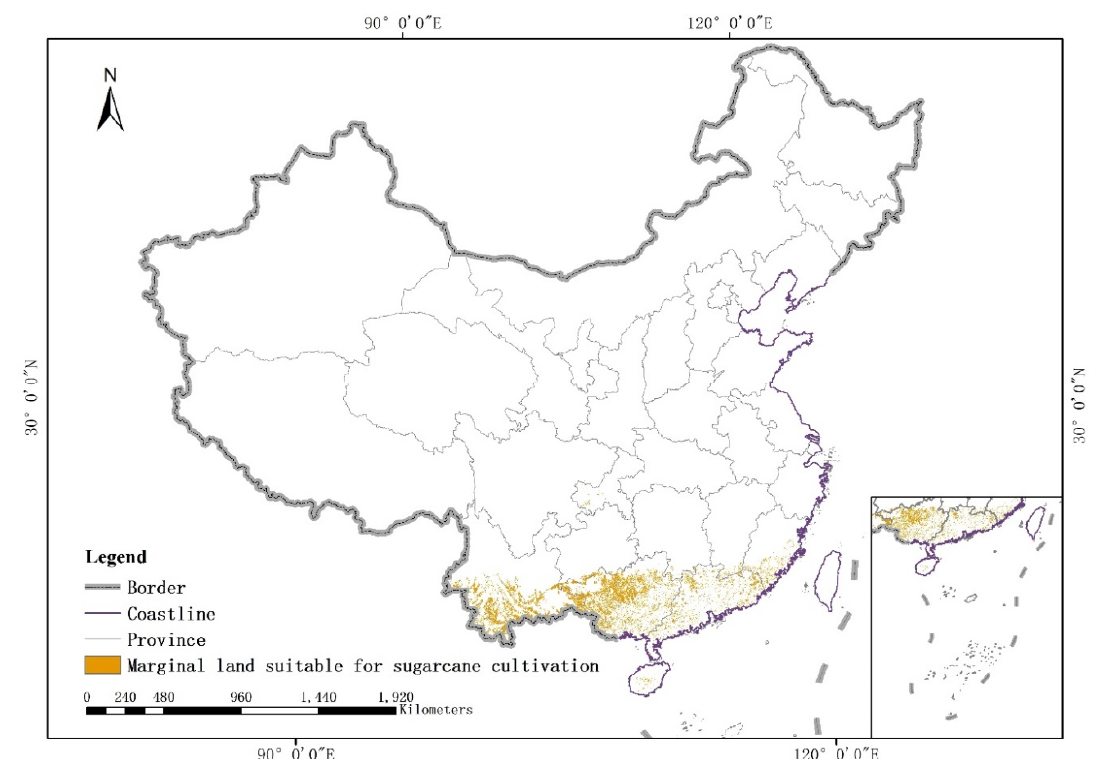
Figure 3. Spatial distribution of marginal land suitable for growing sugarcane in China.